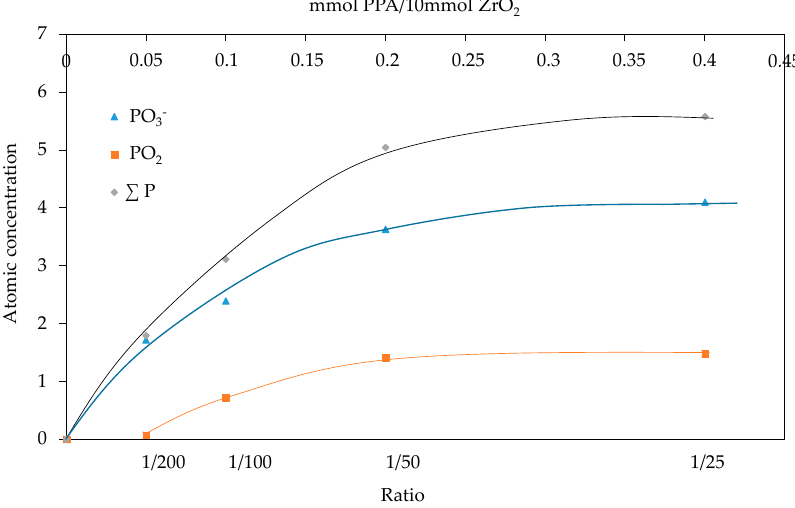
Figure A5. Variation of the surface species content of ZrO 2 as a function of the ratio used, according to X-ray Photoelectron Spectroscopy study of (ZrO 2 ) x (PAA) Samples (Zr/P ratio ( x ) = 25, 50, 100, 200).